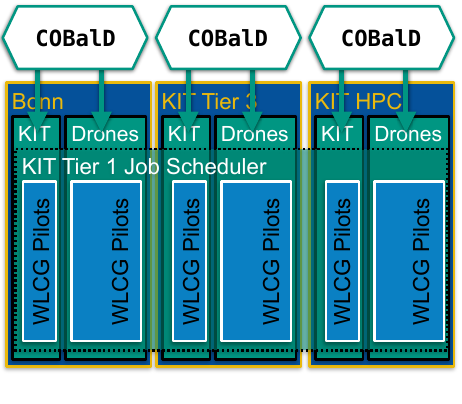
Figure 3. Orthogonal setup of COBalD meta-schedulers and job scheduler at KIT: Independent COBalD instances are deployed for various resource providers, each managing their own set of resources. COBalD uses TARDIS to run drones, the equivalent of pilot jobs, which integrate into a single overlay batch system. The overlay job scheduler, a copy of the regular GridKa Tier 1 scheduler, is the only component aware of all resources. As the job scheduler places WLCG pilots on acquired resources, each COBalD instance observes the usage of its own resource